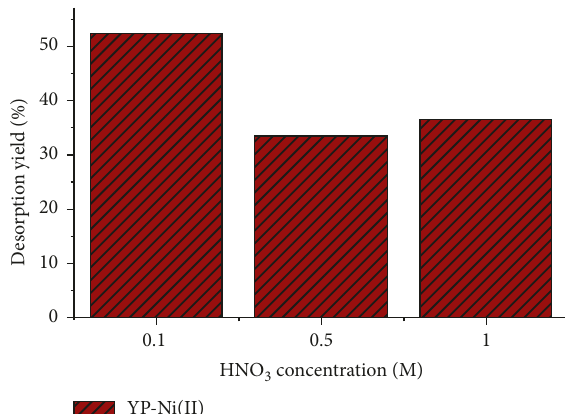
Figure 6: Effect of nitric acid concentration on desorption yield.